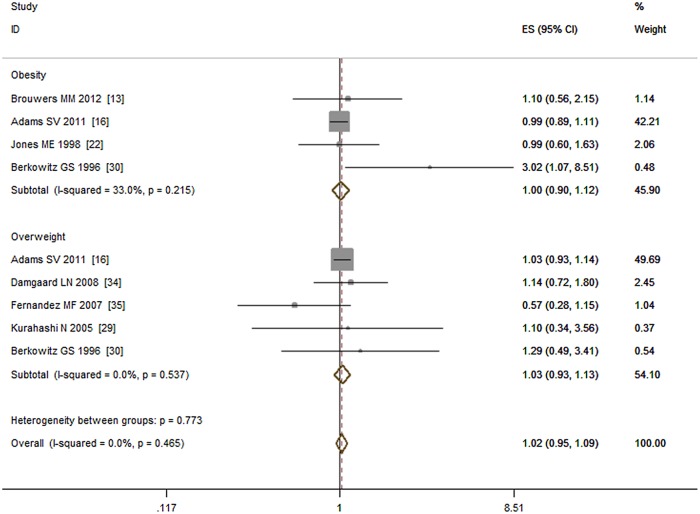
Forest plot for maternal pre-pregnancy BMI and risk of cryptorchidism.Subgroup analysis was conducted by dividing study participants into an obesity group (BMI >30 kg /m2) and an overweight group (25 kg /m2≤ BMI < 30 kg /m2).